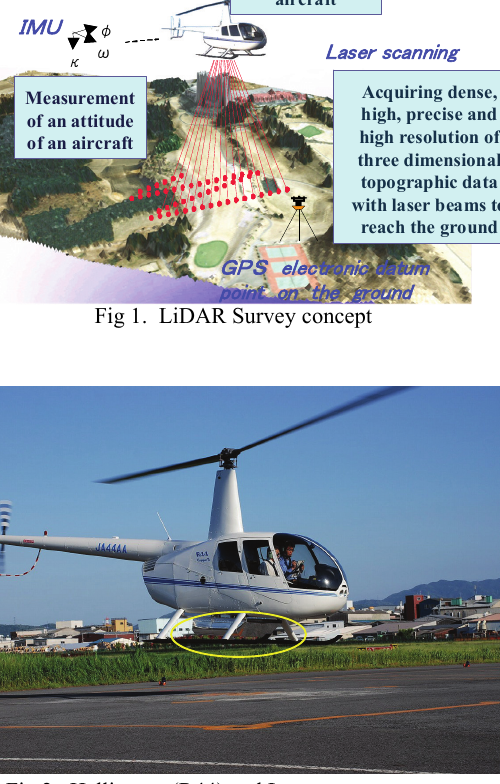
Fig 2. Hellicopter(R44) and Laser scanner system